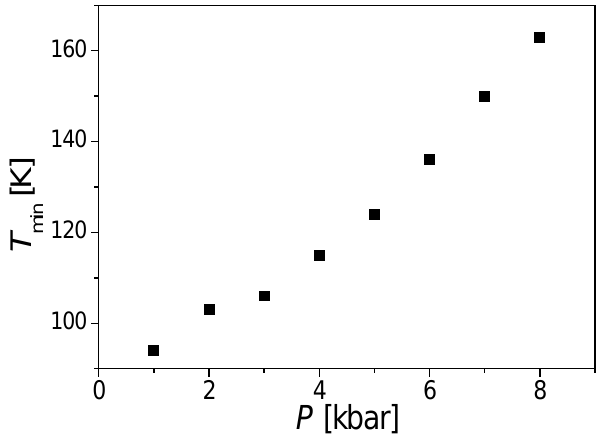
Figure 3. Metal–insulator transition temperature as a function of pressure.